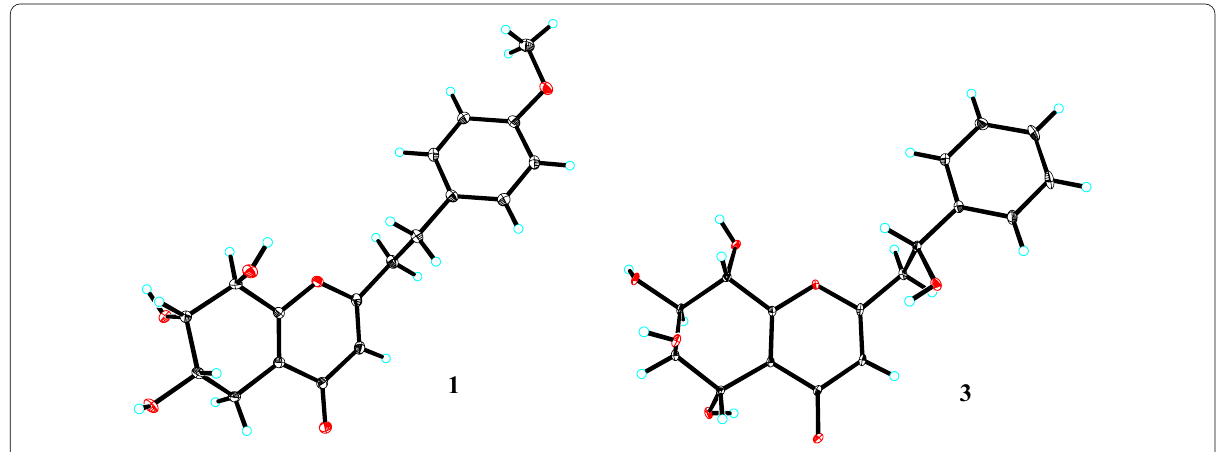
Fig. 3 X‑ray crystallographic structures of 1 and